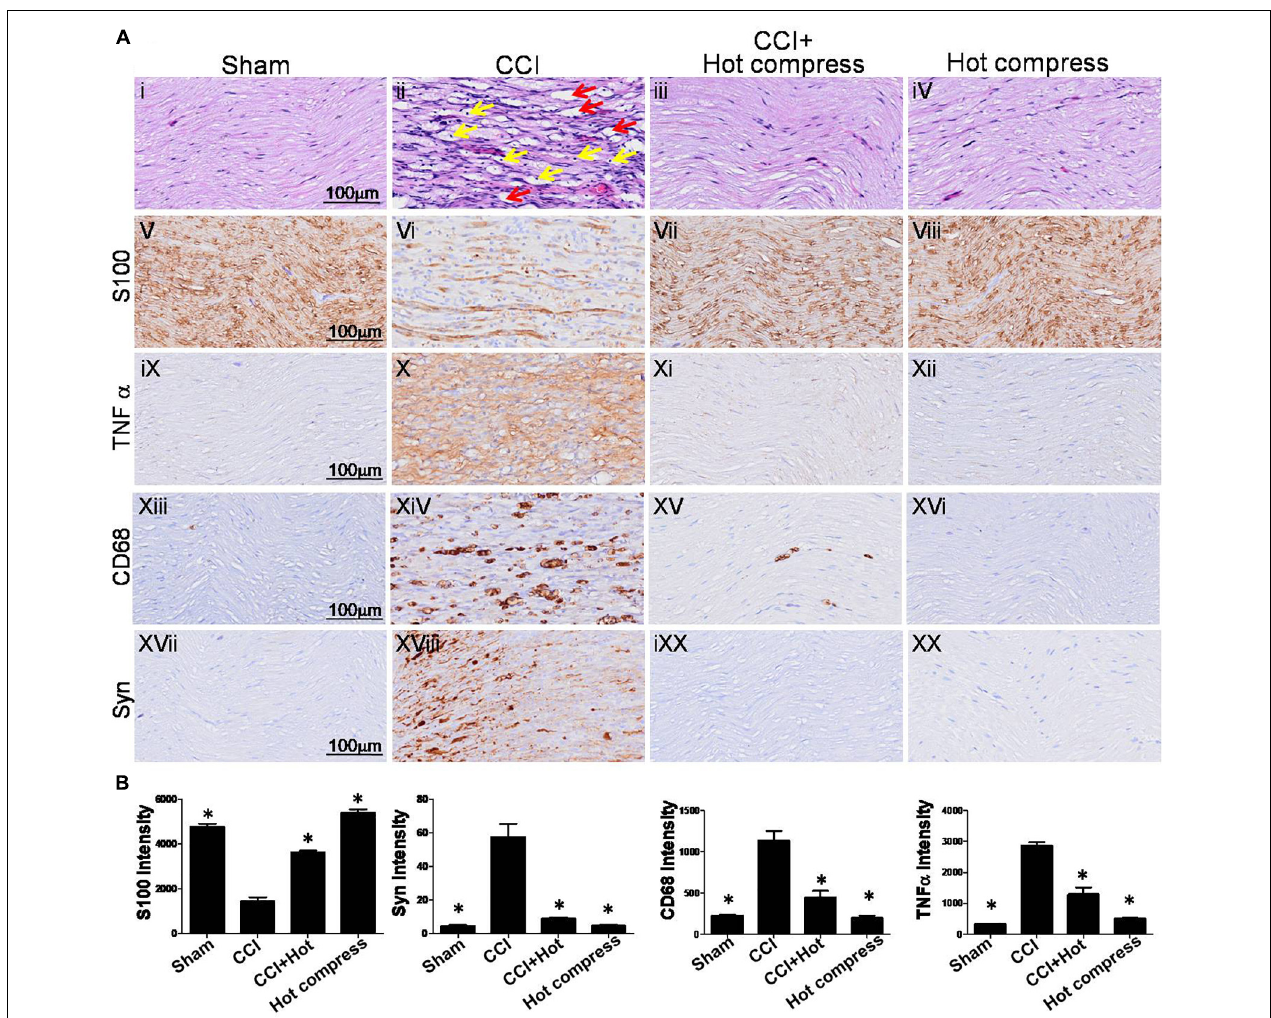
FIGURE 5 | Histological examinations of rat sciatic nerve on the 28th day. (A) Through (i–iv) H&E staining and (v–xx) immuno-histopathological (IHC) staining over the distal end of the nerve in the different groups. Tissue sections from peripheral nervous were stained by IHC with anti-S100 antibody, which indicate location of Schwann cells and anti-CD68 antibody indicate microglia. (i) The sham group showed an organized cellular pattern without edema and infiltration. (ii) The CCI group showed worse cellular changes, the red arrow indicated cellular spaces, and the yellow arrow indicated inflammatory cell infiltration, (iii) the CCI + hot compress group showed minimal infiltration and cellular edema, (iv) the hot compress alone group not pathological effects. (v–viii) S100 and (xvii–xx) Syn immunoreactivity is seen for nerve injury markers in different groups and nerve pathology was confirmed. For (ix–xii) TNF α and (xiii–xvi) CD68, immunoreactivity is also seen localizing to the nerve inflammation dysphonic site. (B) A quantitative analysis of expression level of S100, Syn, TNF α , and CD68 in the different groups. Data were analyzed by one-way ANOVA with post hoc Dunnett’s test. ∗ p < 0.001 was considered significant as compared with the CCI group, n = 8. Bar, 100 µ